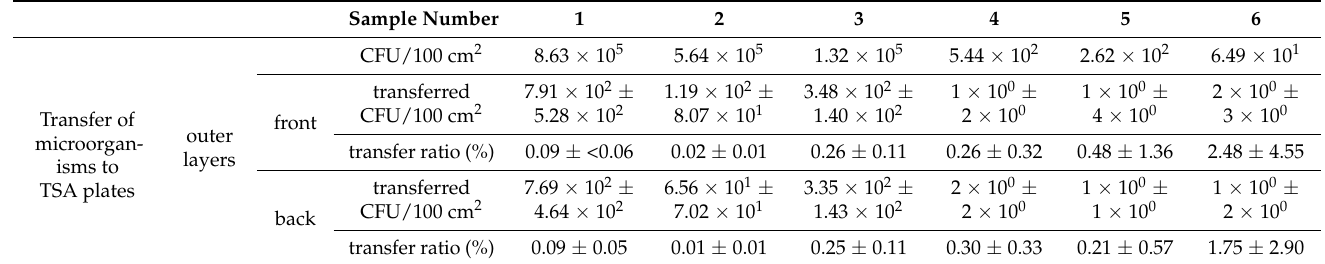
Table 2. Determination of the microbial transfer from the front and back of tested samples to tryptone soy agar (TSA) plates. The samples are labeled with respect to their numbers of colony-forming units per 100 square centimeters (CFU/100 cm 2 ) in descending order (1–6). Data are shown as mean ± SD. The transfer ratios are declared as a percentage (%). A p -value of <0.05 was defined as statistically